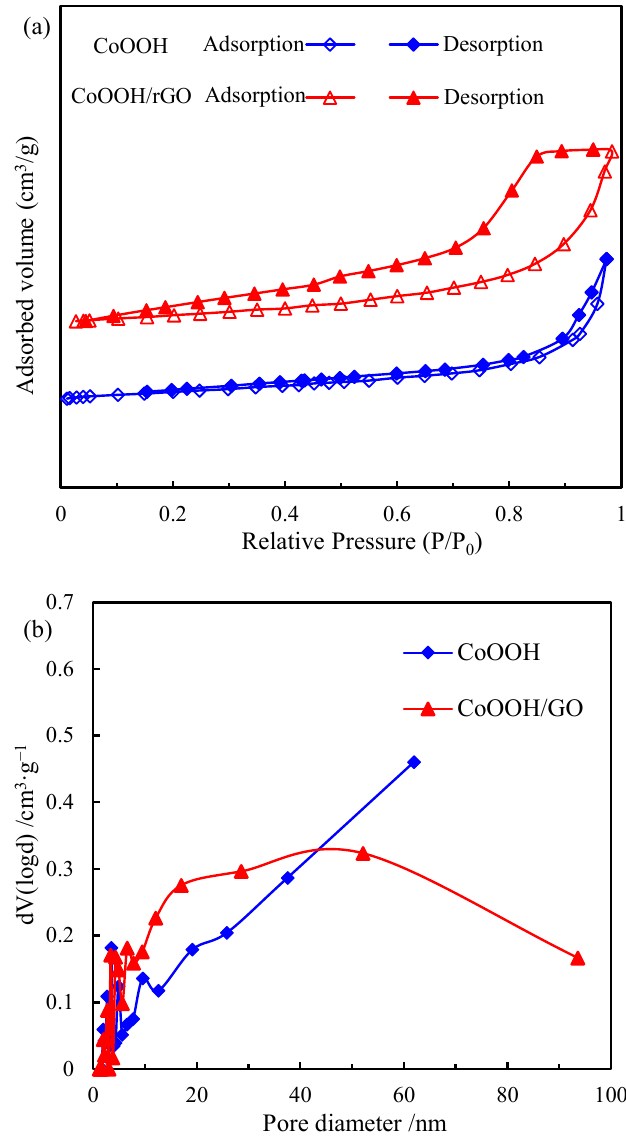
Figure 3. ( a ) N 2 adsorption-desorption isotherm curves and ( b ) BJH pore size distributions of pure CoOOH and CoOOH/rGO nanocomposite. Table 1. The surface properties of pure CoOOH and CoOOH/rGO.